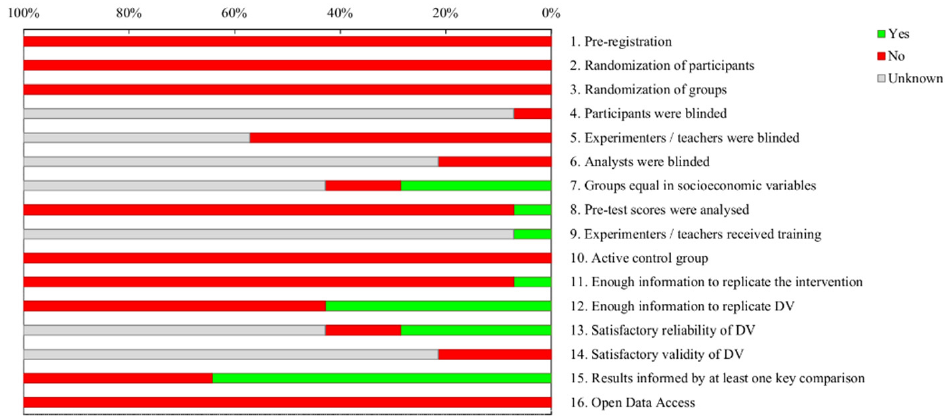
Figure 3. Overview of the quality of the articles included.